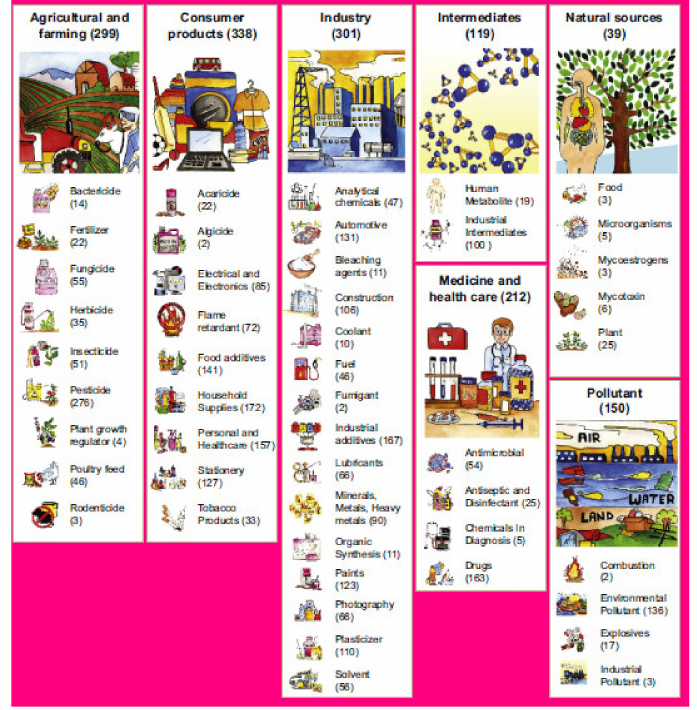
Figure 1. Classification of EDC pollutants